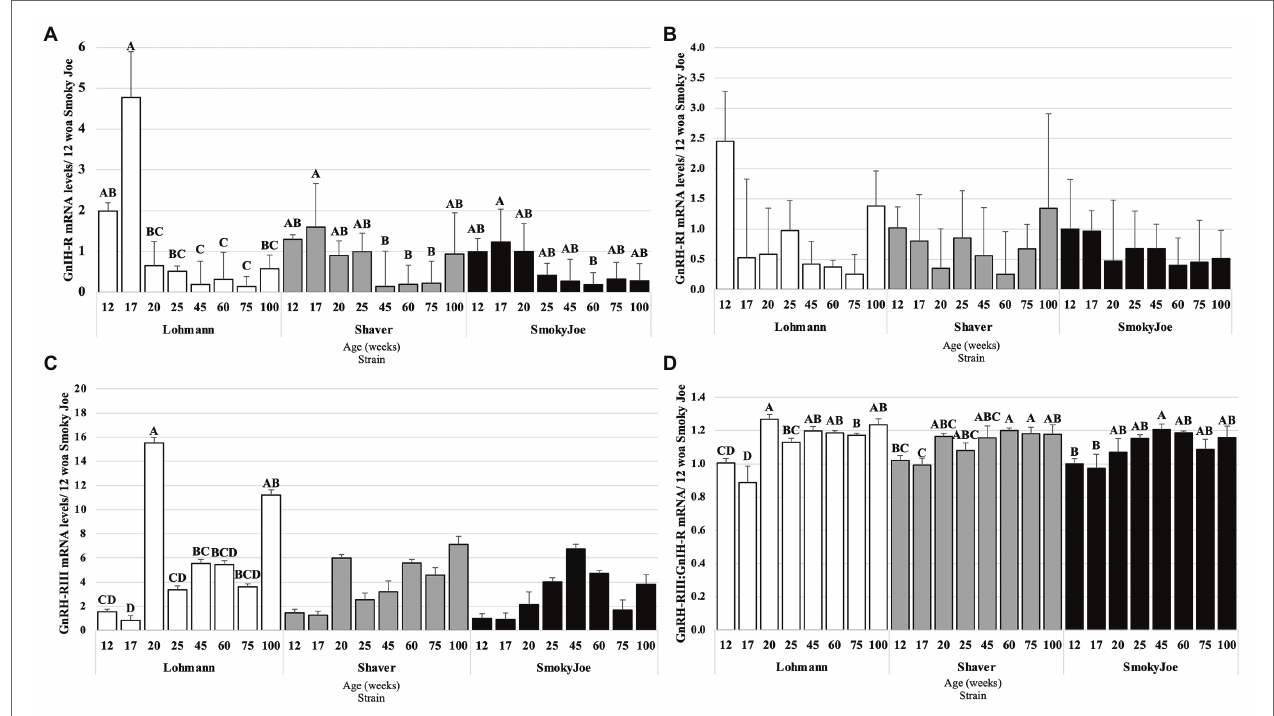
FIGURE 8 | Gonadotrophin-Inhibiting Hormone Receptor (GnIH-R; A ), Gonadotrophin-Releasing Hormone Receptor I (GnRH-RI; B ), and Gonadotrophin-releasing hormone receptor III (GnRH-RIII; C ) mRNA expression levels in Lohmann, Shaver, and Smoky Joe hens at 12, 17, 20, 25, 45, 60, 75, and 100 woa. (D) Ratio between GnRH-RIII and GnIH-R mRNA levels. p -values for the sources of variation of age by strain: (A) Lohmann, p < 0.0001; Shaver, p = 0.0034; and Smoky Joe, p = 0.0061. (B) Lohmann, p = 0.0506; Shaver, p = 0.1885; and Smoky Joe, p = 0.8869. (C) Lohmann, p < 0.0001; Shaver, p = 0.0258; and Smoky Joe, p = 0.0997. (D) Lohmann, p < 0.0001; Shaver, p = 0.0012; and Smoky Joe, p = 0.0086. A,B,C,D Data points lacking the common superscript differ significantly within the ages of each strain, while no superscript did not differ from any other time point in that